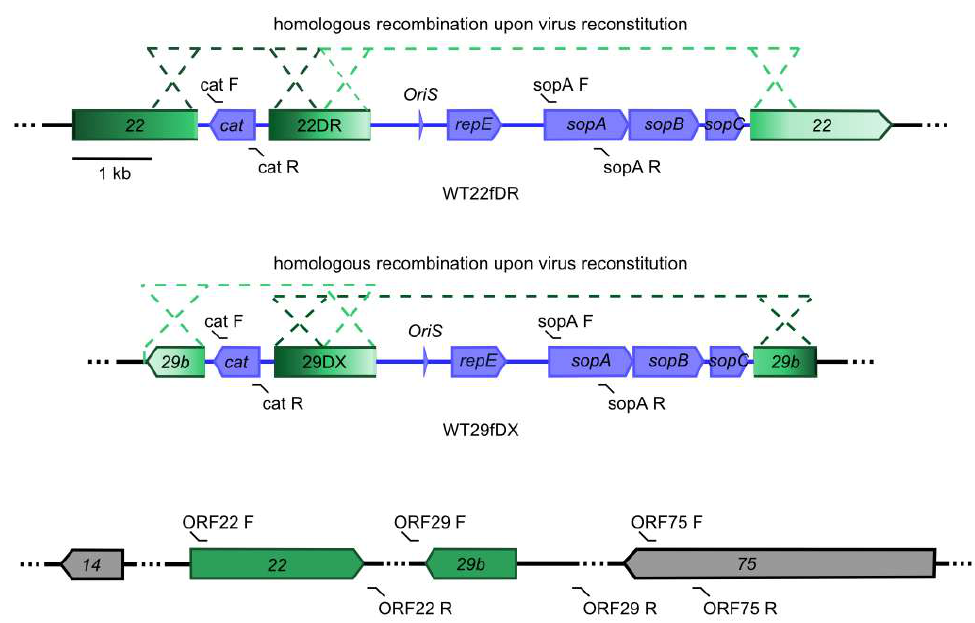
Figure 1. Scheme of the two separate recombination events which constitute the viral self-repair of herpesvirus saimiri (HVS) virus variants within permissive epithelial cells. In the upper panel, WT22fDR carries direct repeats of ORF22 while in the middle panel, WT29fDX carries inverted repeats of ORF29b (indicated by color gradients). The primer combinations used to monitor viral self-repair by PCR are indicated (F: forward primer, R: reverse primer). In the lowest panel, the self-repaired virus genome is shown without F plasmid vector moiety (miniF) sequence (orange-colored genes). The resulting DNA is free of residual base pairs and the ORFs previously harboring the miniF are restored to their original state. Images taken and modified from [27].